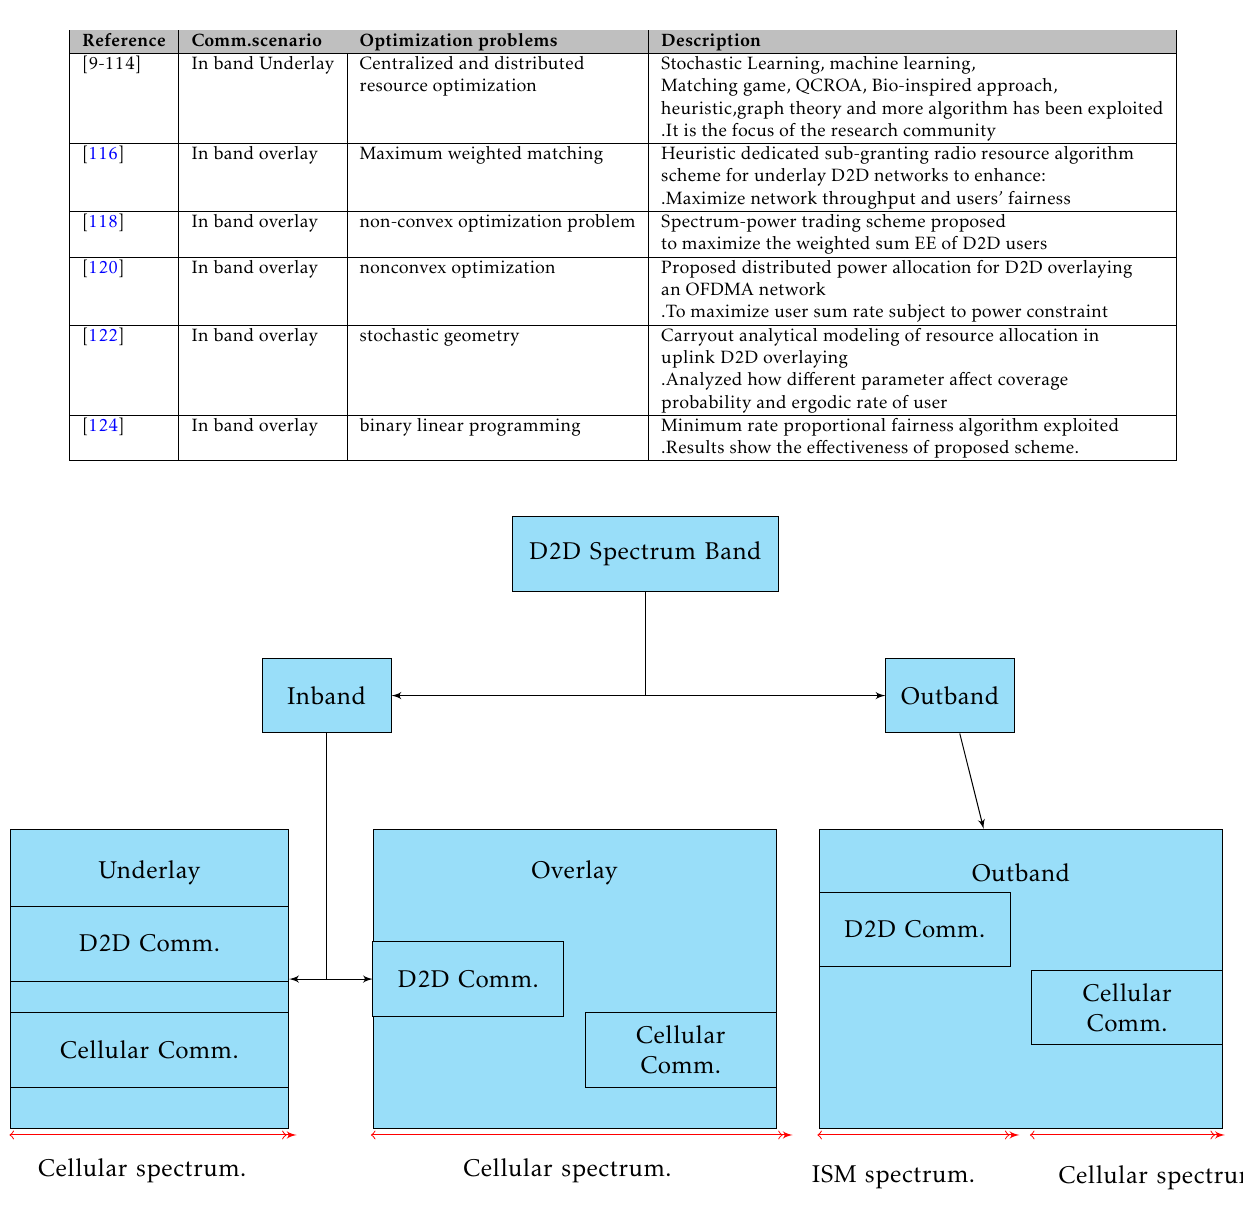
Table 5. Underlay and Overlay D2D Resource Allocation